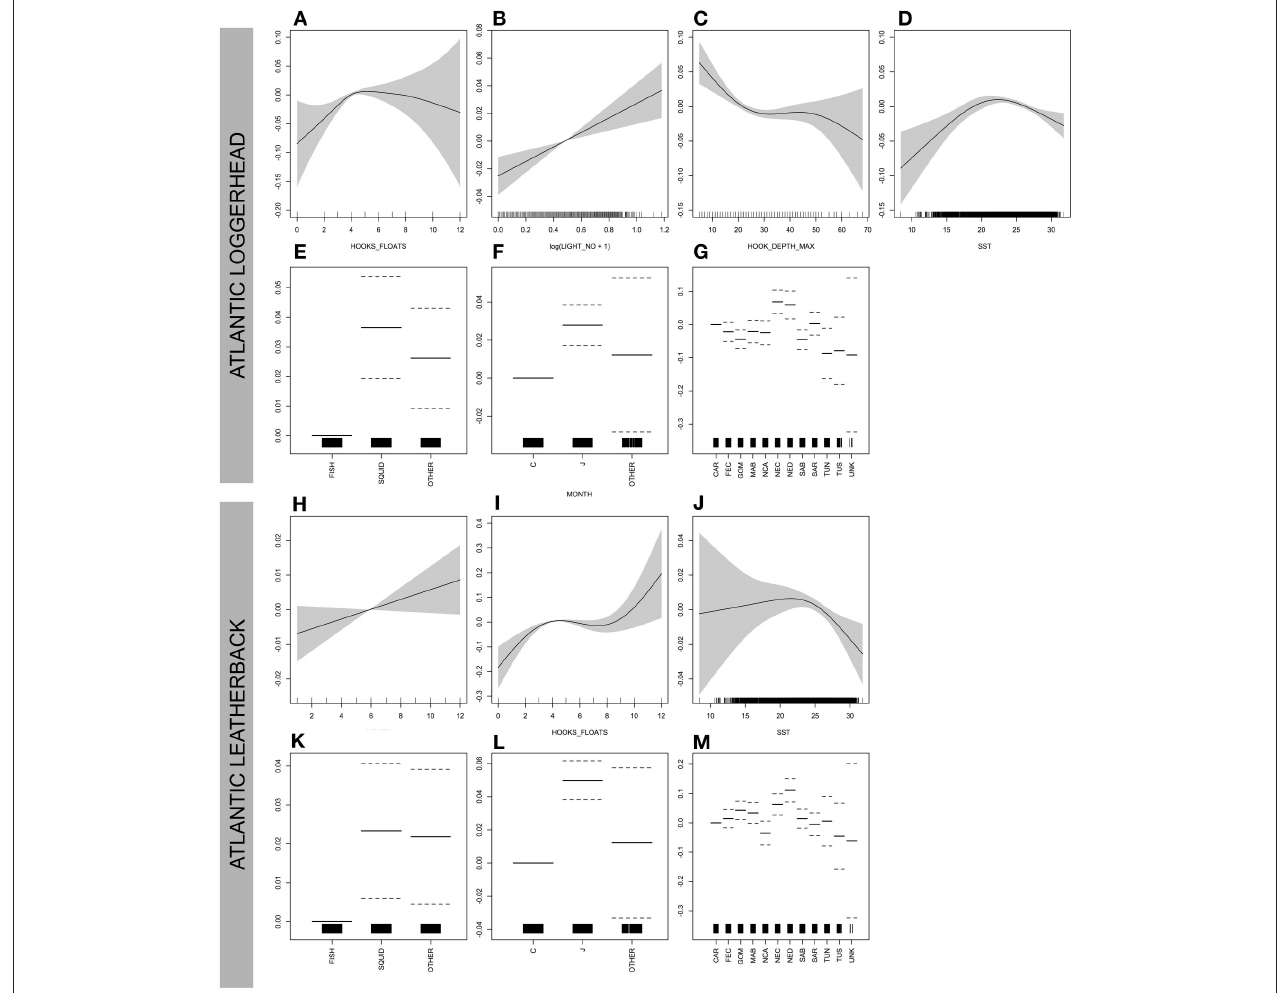
FIGURE 7 | Effect of gear characteristics and weekly averaged satellite derived sea surface temperature (wSST) on catch probability of loggerhead (A–G) and leatherbacks in the Atlantic Ocean (H–M) . The y-axis is in logit units and represents deviation from the logit mean. The smoothed probability of catch is scaled by its coefficient from the Generalized Additive Mixed Model (GAMM) model. The shaded area represents the upper and lower twice-standard-error curves. For factors (categorical variables), solid lines are the mean and the first factor is the reference group centered at zero, dashed lines represent upper and lower twice-standard errors. Positive (negative) values represent higher (lower) probability of catch from the mean capture probability. Vertical ticks on the x-axis indicate data distribution. For the Atlantic, the probability of loggerhead turtle capture is a function of (A) number of hooks between floats, (B) ratio of light sticks to hooks (log scale due to improve model fit), (C) maximum reported hook depth, (D) SST, (E) Bait type, (F) Hook Type, (G) Statistical Reporting, area. For the Atlantic, the probability of leatherback turtle capture is functional of (H) Month, (I) Number of hooks between floats, (J) , SST, (K) Bait Type, (L) Hook Type, (M) Statistical Reporting